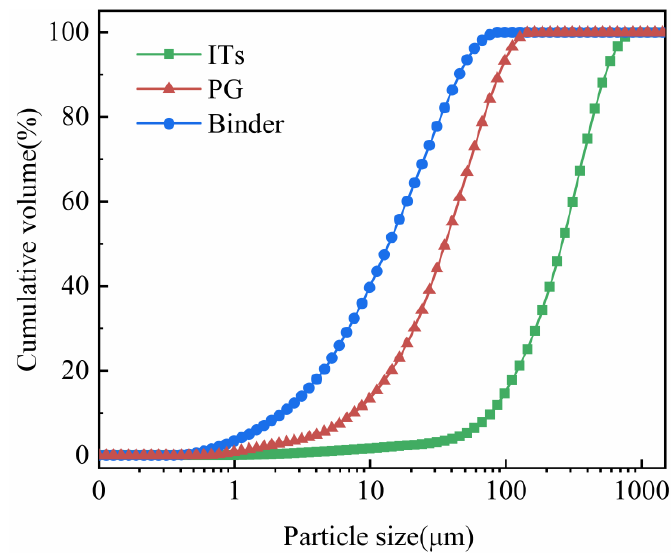
Figure 1. Particle size distribution of PG, binders and ITs. The diffraction patterns of the ITs and PG were characterized via X-ray diffraction (XRD) using a D8 X-ray automatic diffractometer (Bruker, Billerica, MA, USA) with a resolution of 0.02°/s in the angular domain 5 – 80°, and the results are shown in Figure 2. The chemical composition of ITs, PG and binder were measured through an X-ray fluorescence analyzer (Bruker, Billerica, MA, USA), as shown in Table 1.